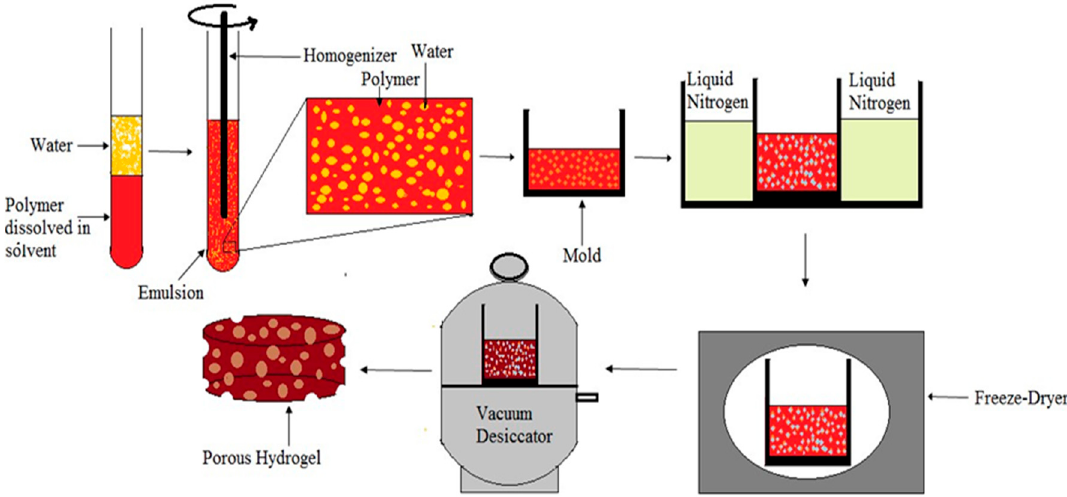
Figure 10. The schematic diagram of emulsion freeze-drying process.